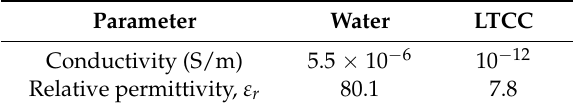
Table 1. Parameters of water and low temperature co-fired ceramic (LTCC) materials used in simulations.